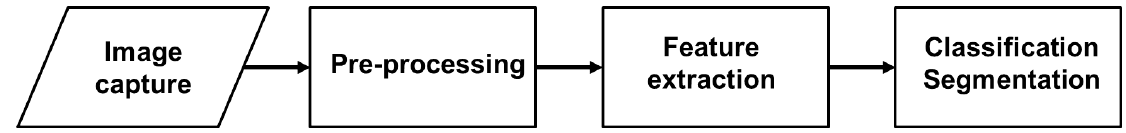
Figure 2. The classical processing chain for satellite image